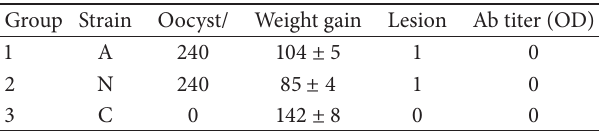
Table 1: Six White Leghorn birds/group were inoculated with normal (N) or altered (A) oocysts of E. tenella and euthanatized 1 week after. Control (C) birds received sham inoculation (0). Body weight